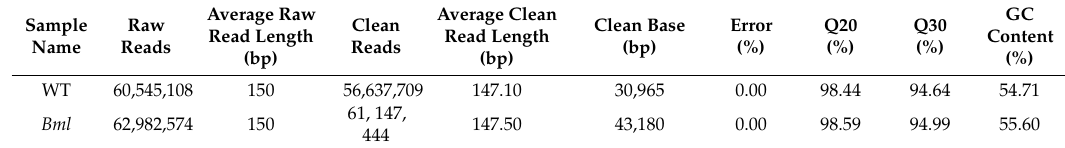
Table 1. Reads summary of samples by Illumina deep RNA sequencing.